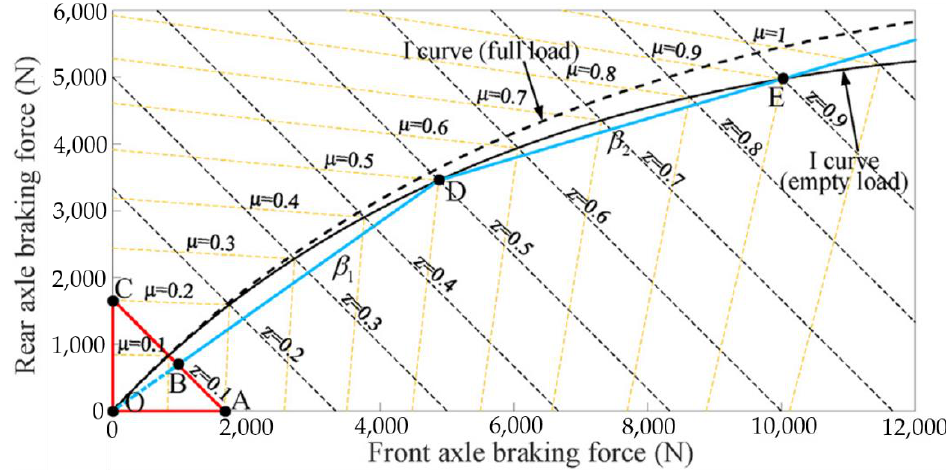
Figure 7. Control map for braking force distribution between the front and rear axles.